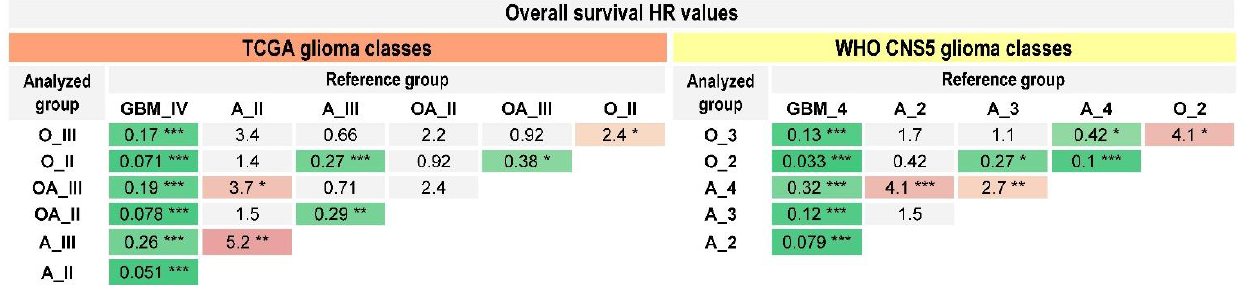
Figure 9. Pairwise comparisons for overall survival for patients with diffuse gliomas according to the basic TCGA and the WHO CNS5 classifications. CI — confidence interval; HR — hazard ratio.